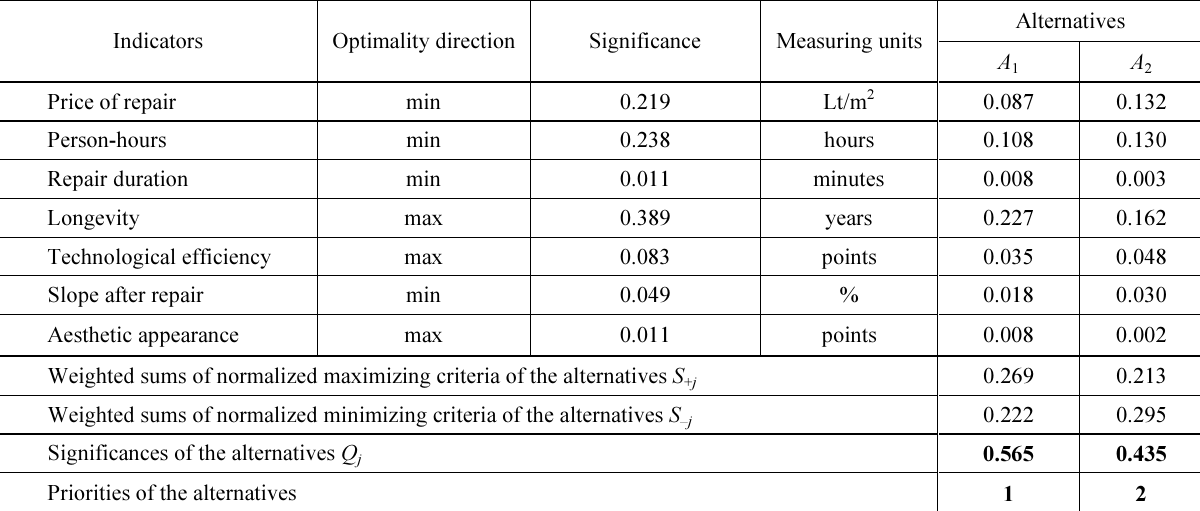
Table 2. The results of calculation applying COPRAS method